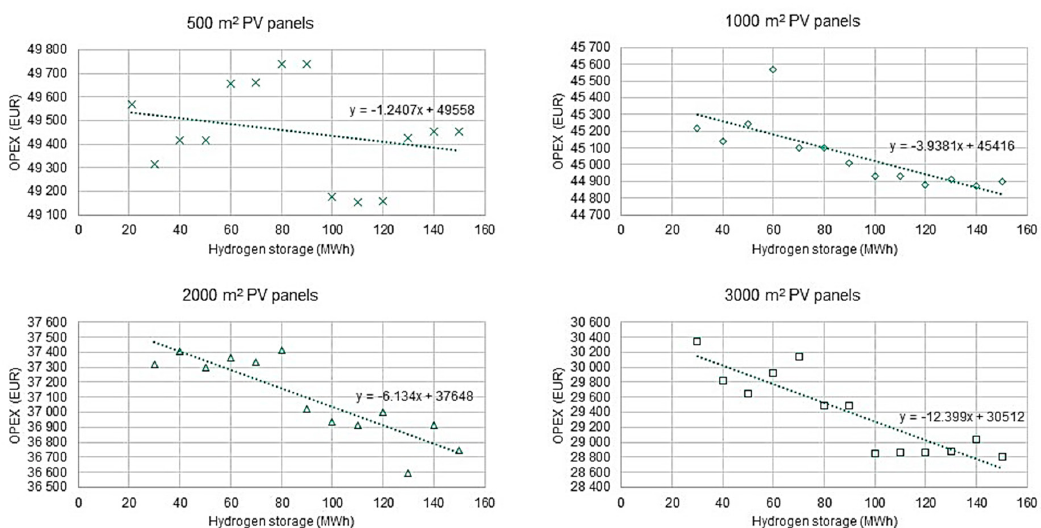
Figure 12. Optimal OPEX of the 50/200 kW RSOC system as a function of the hydrogen storage capacity for different solar PV installations.